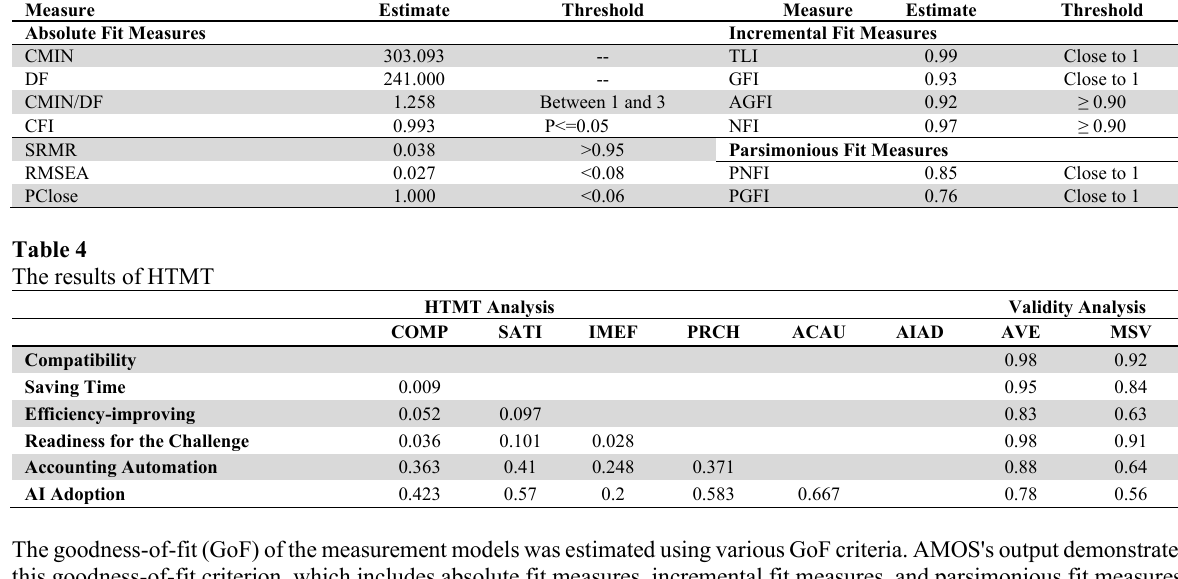
Model Fit Measures Measure